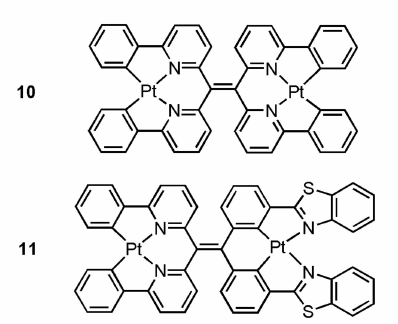
Figure 3. Structures of Pt(II) complexes 10 and 11 . Adapted from ref. [38].